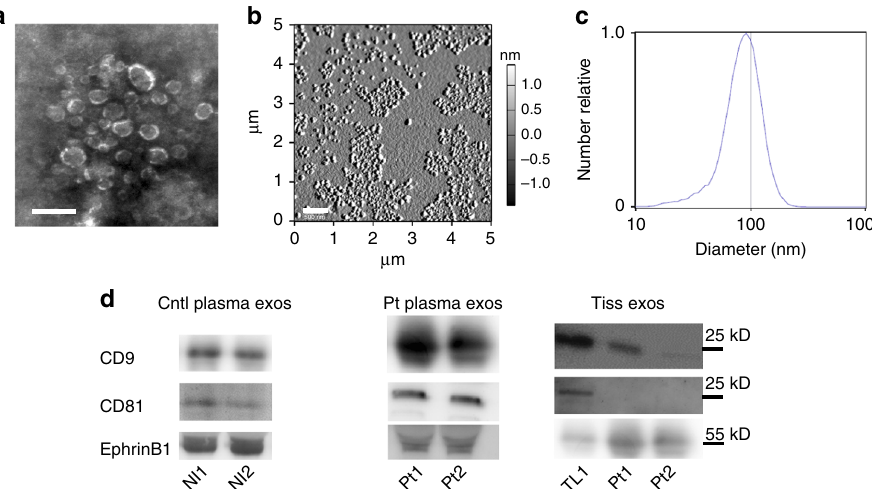
Fig. 2 Validation of human exosome puri fi cation. a Scanning electron micrograph of exosomes puri fi ed from human plasma. Scale bar, 200 nm. n = 4 biological samples. b Atomic force microscopy amplitude trace of exosomes puri fi ed from human plasma. Size range, 63 – 105 nm. Scale bar, 500 nm. n = 7 biological samples. c Representative nanoparticle tracking analysis of exosomes puri fi ed from human plasma. N = 4 biological samples. d Western blot analysis of control (Cntl) and patient (Pt) exosomes (exos). Western blots have been cropped for clarity and conciseness. Nl1-2 plasma from healthy volunteers, TL 1 normal adult tonsil. n = 3 technical